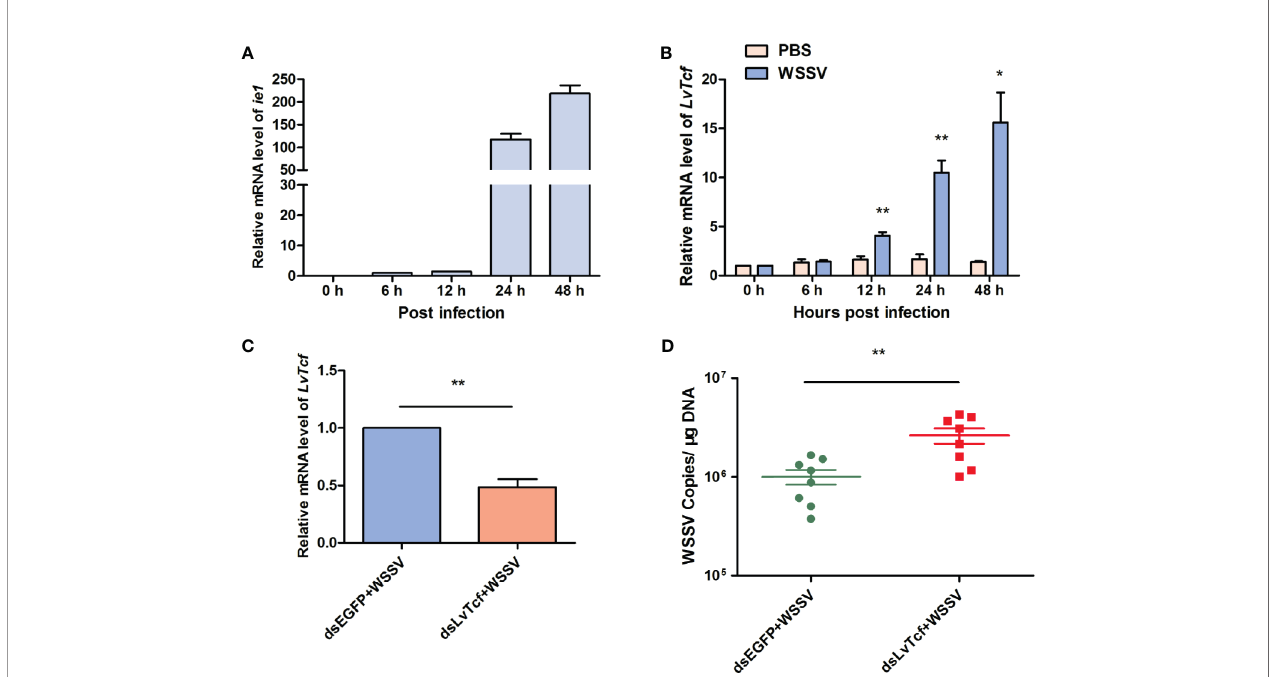
FIGURE 1 | LvTcf played a protective role against WSSV infection. (A, B) LvTcf expression following WSSV infection. Expression of WSSV immediately early gene ie1 (A) and LvTcf (B) after WSSV challenge, as determined using qRT-PCR. Hemocytes were collected at 0, 6, 12, 24, 48 h post-WSSV injection. LvEF-1 a was used as internal control. (C, D) Effects of LvTcf on WSSV infection. (C) The expression level of LvTcf after RNAi. (D) Silencing of LvTcf facilitated WSSV proliferation. DsRNA-LvTcf and dsRNA-eGFP (control group) were injected into shrimp. After 24 h, the two groups were infected with 1×10 5 WSSV virions. The number of WSSV copies in gills (n = 8) were assessed at 48 h post-infection by absolute q-PCR. LvEF-1 a was used as internal control. All the experiments were performed in triplicate. The data were statistically analyzed via the student ’ s t -test (*p < 0.05, ** p <